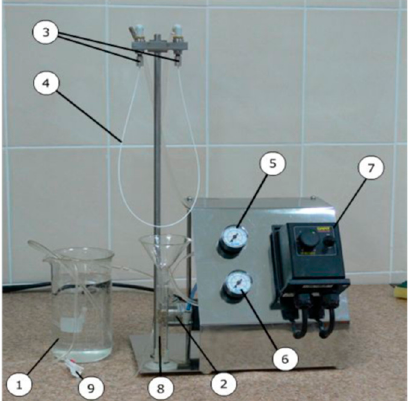
Figure 1. Laboratory set-up for the testing of individual hollow fiber membranes: 1—vessel with the feed solution; 2—pump; 3—clamps for fixation of hollow fiber membranes; 4—hollow fiber membrane; 5—manometer (inlet pressure); 6—manometer (outlet pressure); 7—control unit of the pump; 8—measuring cylinder for permeate; 9—pressure regulating valve.